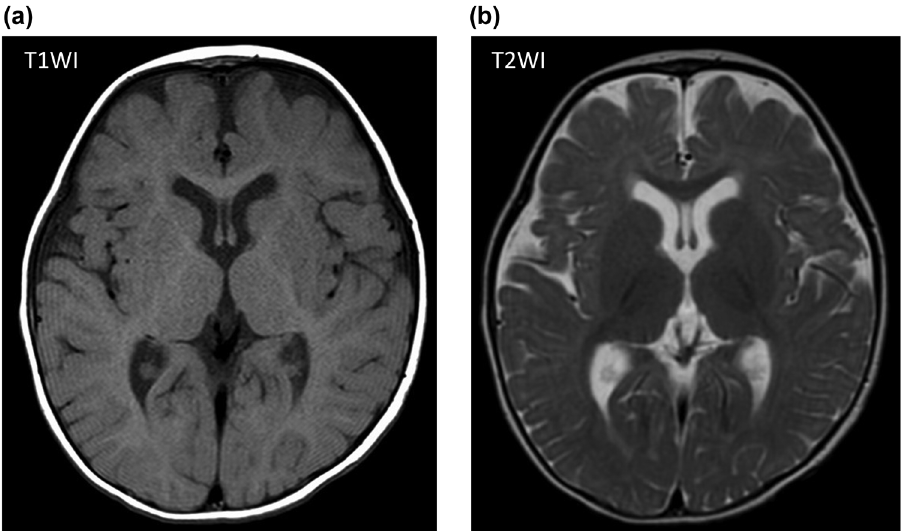
Figure 3: Brain magnetic resonance imaging scans of the patient at 1 year of age. ( a ) Axial T1 - weighted imaging did not show hypointensities in the globus pallidus bilaterally ( a sign of kernicterus ) and ( b ) T2 - weighted imaging did not show areas of increased signal intensity in the globus pallidus bilaterally ( a sign of kernicterus )